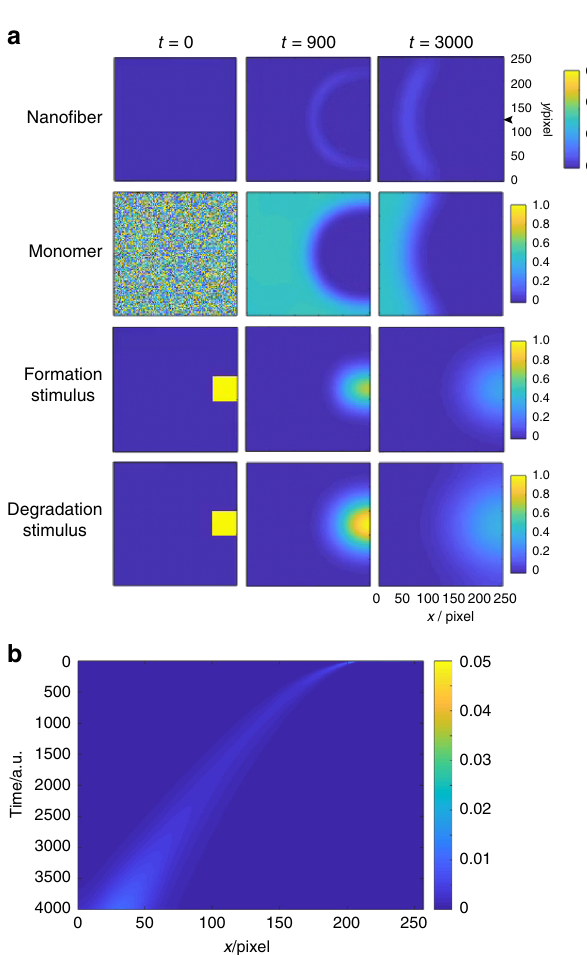
Fig. 2 In situ real-time imaging of a propagating wave of supramolecular nano fi bers. a Schematic illustration of the experimental setup. A solution of BPmoc-F 3 , BP-TMR, and GOx was placed between two glass plates. One minute after starting confocal laser scanning microscopic (CLSM) observation, two stimuli were added via a syringe from the right edge of the droplet. b , e Time-lapse CLSM imaging of the propagating wave of supramolecular nano fi bers observed by b 100× and e 4× objectives. b A solution of Zn(NO 3 ) 2 and glucose was injected from the right side of images, and e the injection point was highlighted by an arrowhead. c , d , f Time-course of fl uorescent intensity at distinct x -coordinates under the propagating wave ( c Fig. 2b and f 2e) and d homogeneous nano fi ber degradation (Supplementary Fig. 15). The shape of the crescent-shaped area varied depending on experiments because injection of the chemical stimuli was conducted manually; nevertheless the formation of the propagating wave is highly reproducible (Supplementary Fig. 10). Condition: [BPmoc-F 3 ] = 1.6 mM, [BP-TMR] = 0.34 µ M, [GOx] = 1.0 mg/mL, [Zn(NO 3 ) 2 ] = 0.8 mM, [glucose] = 3.2 mM in 50 mM HEPES, pH 7.4, 30 °C.